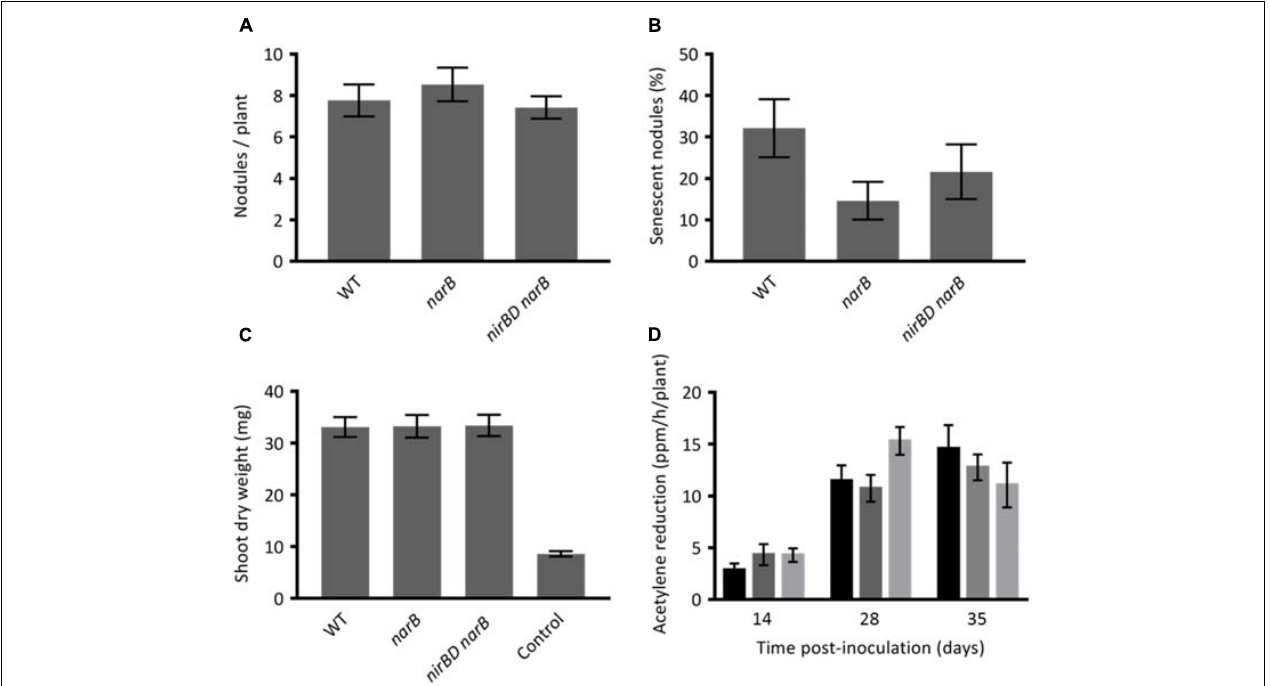
FIGURE 7 | Phenotypes of Medicago truncatula inoculated with narB or nirBD narB mutants. M. truncatula plantlets were inoculated with S. meliloti WT or mutant strains. (A) The number of nodules per plant (19 to 27 plants were tested). (B) Percentage of senescent nodules. A nodule was estimated senescent when a green color was visible on a significant surface of the nodule (19–27 plants were tested). (C) The dry weight of the aerial part of the plant (18–20 plants were tested). These three parameters were tested 5 weeks post-inoculation. (D) The nitrogen fixation activity was assessed by using the acetylene reduction assay (ARA). ARA was performed at 14, 28, and 35 dpi on whole plants inoculated with the WT strain (black bars), narB mutant (dark gray bars) or nirBD narB mutant (light gray bars). For each strain and time point 7–9 plants were tested. All values are the mean ± standard error of the mean